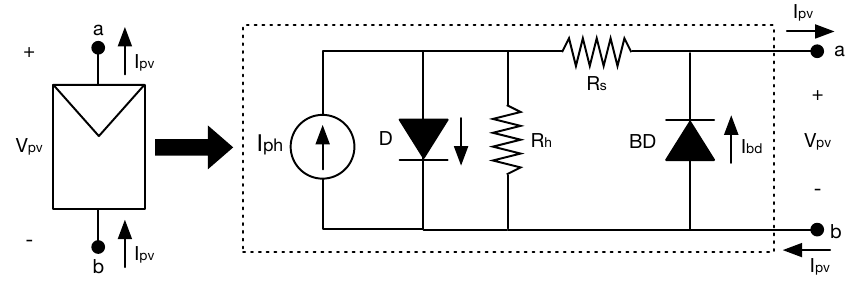
Figure 1. Single-diode model of a